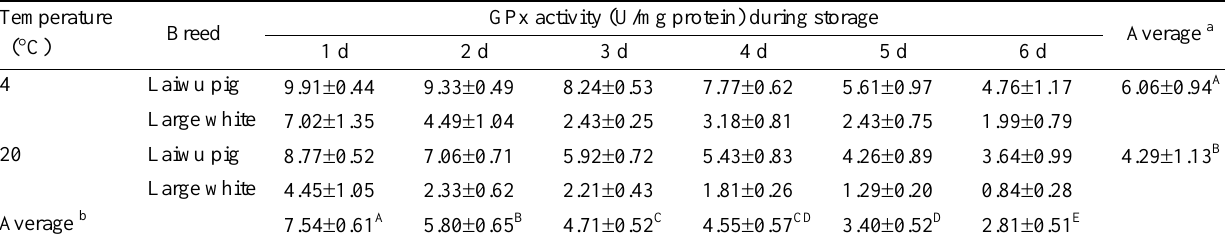
Table 3. GPx activity of porcine muscle stored at different days and temperatures